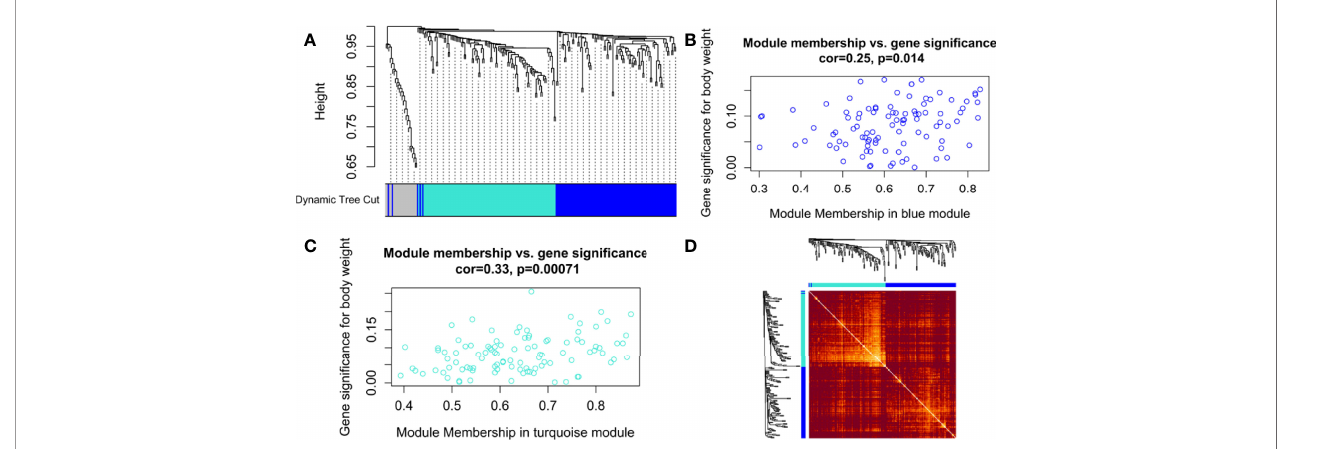
Figure 4D . The highest correlation of 0.559 was observed within the plot between SOX2 and WNT3A, while the lowest correlation of 0.138 was observed between SOX2 and MAF.